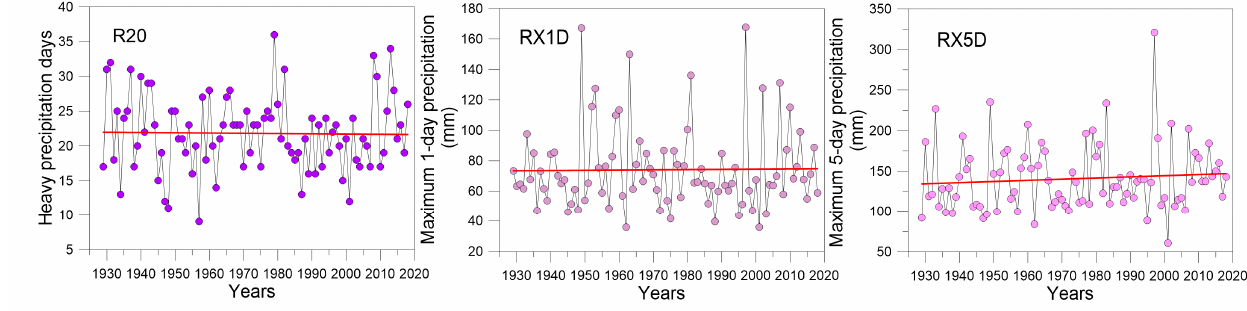
Figure 5. Representation of the series of the 12 climate change indices established by ETCCDI and described in Table 2.